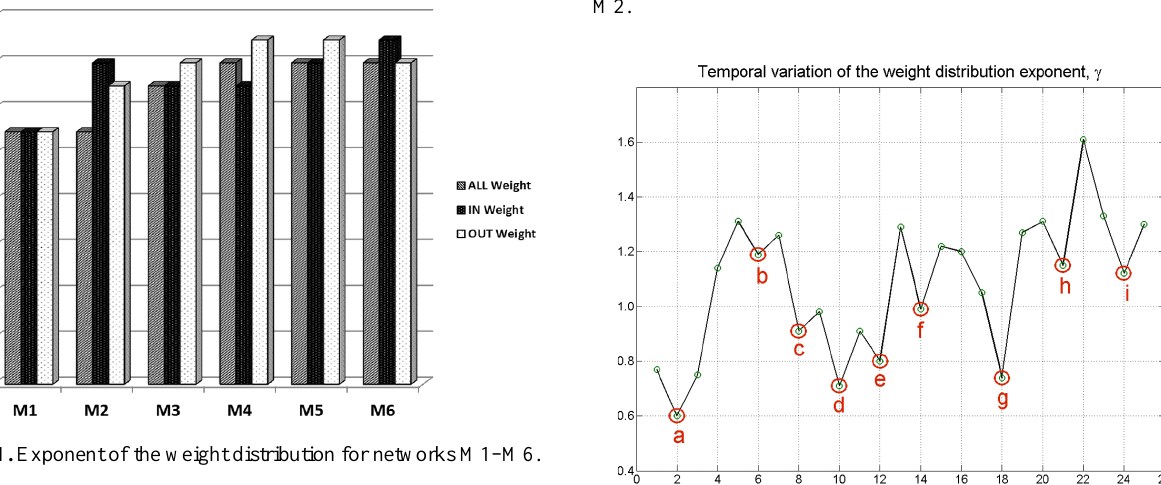
Fig. 12. Temporal variation of the connectivity distribution expo- nent (absolute value) in successive temporal windows of network M2.